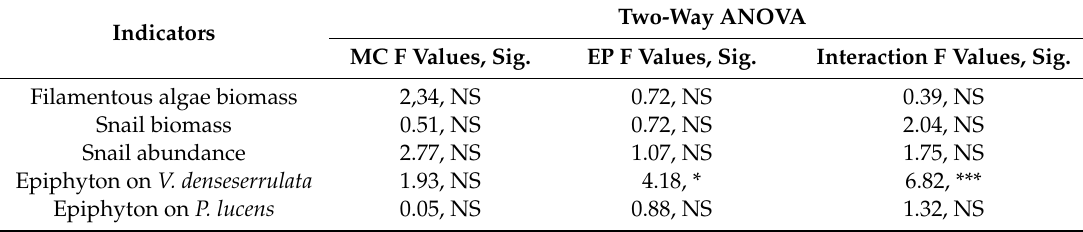
Table 3. Statistical summary of two-way ANOVA on the e ff ects of macrophyte community (MC: MC1, MC2 and MC3) and extreme precipitation (EP: C, C_N, E and G) on the biomass (or abundance) of filamentous algae, snails and epiphyton at the end of the experiment. NS = not significant; * = p < 0.05; *** = p < 0.001. Two-Way ANOVA Indicators MC F Values, Sig. EP F Values, Sig. Interaction F Values,